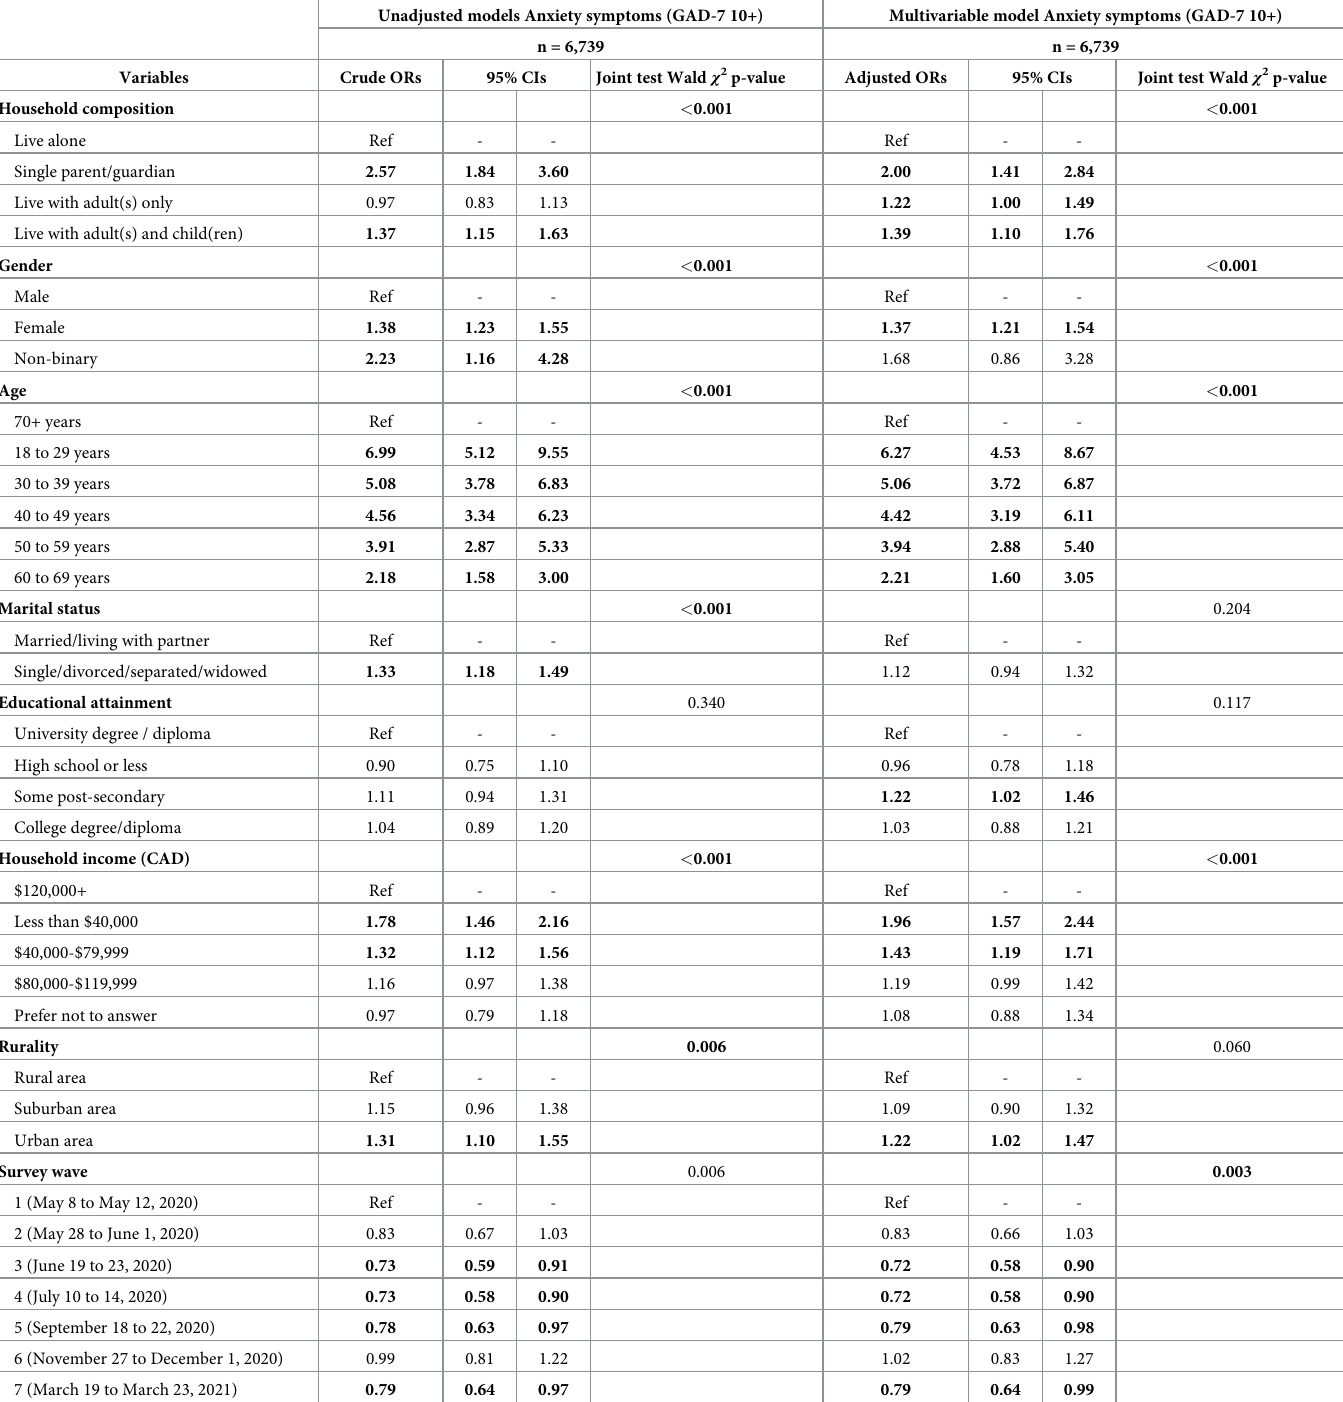
Table 2. Unadjusted and multivariable logistic regression models for anxiety symptoms (GAD-7 10+), Canadian adults aged 18+ years during the COVID-19